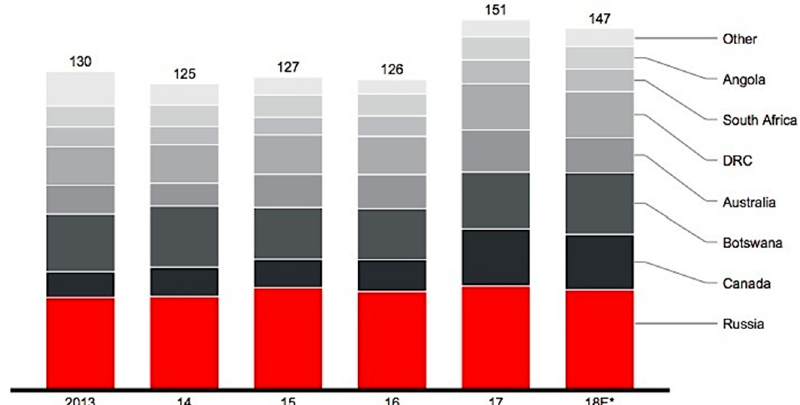
Figure 1. Annual rough diamond production by country in billions of U.S. dollars (2013–2018). Notes: The figure presents annual rough diamond production by country in billions of dollars. Only diamonds tracked by Kimberley Process are included. 2018 data is preliminary estimate. DRC is Democratic Republic of the Congo. Source : (Bain and Company, Antwerp World Diamond Center 2018). value chain that has been achieving the highest profit margins, as reported in Figure 2.